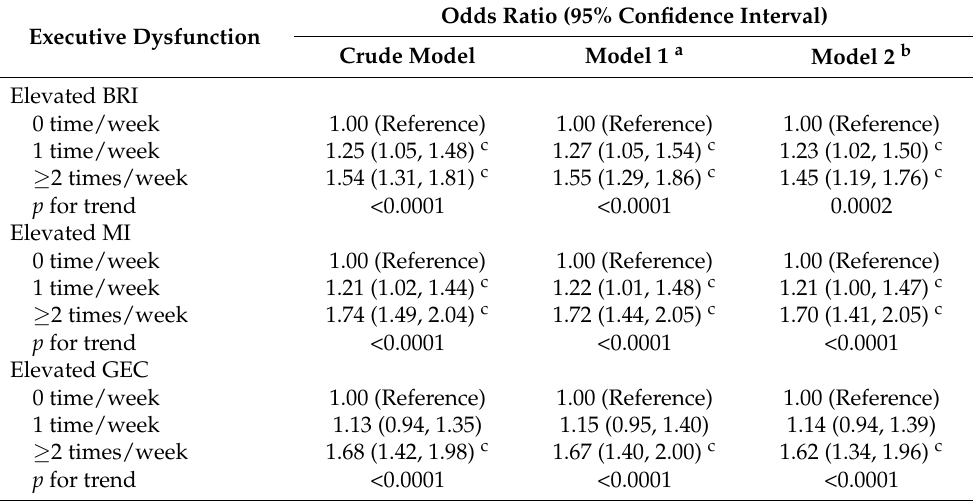
Table 3. Association between SSB consumption with executive dysfunction ( n =